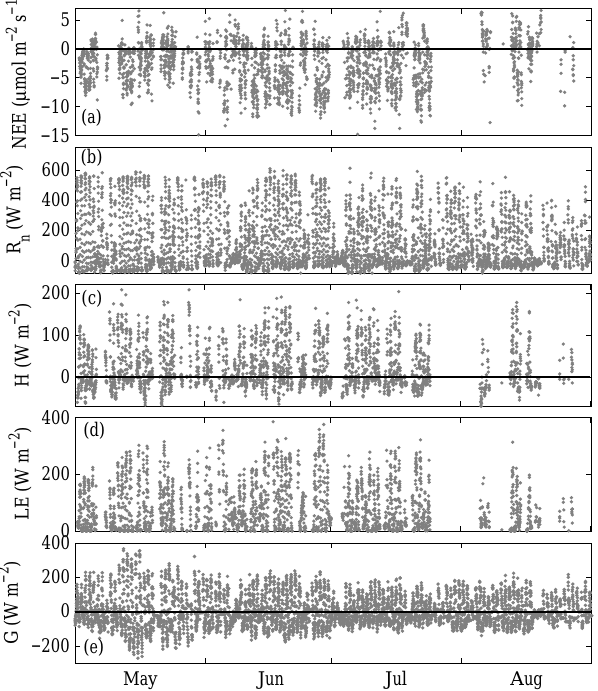
Figure 4. Time series of the 30min average surface fluxes mea- sured with the eddy covariance system: (a) net ecosystem ex- change, (b) net radiation, (c) sensible heat, (d) latent heat, and (e) ground heat flux.